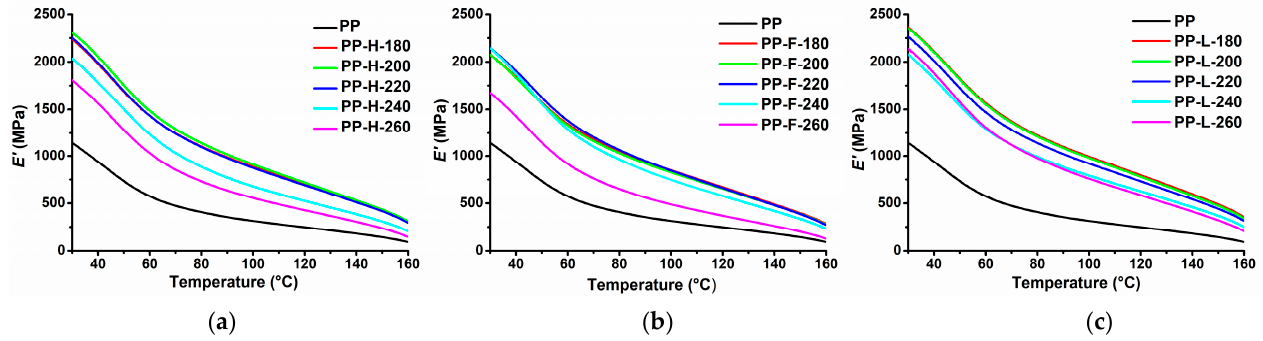
Figure 7. Storage modulus as a function of the temperature of composites processed at different temperatures: ( a ) PP/hemp; ( b ) PP/flax; ( c ) PP/Lyocell.